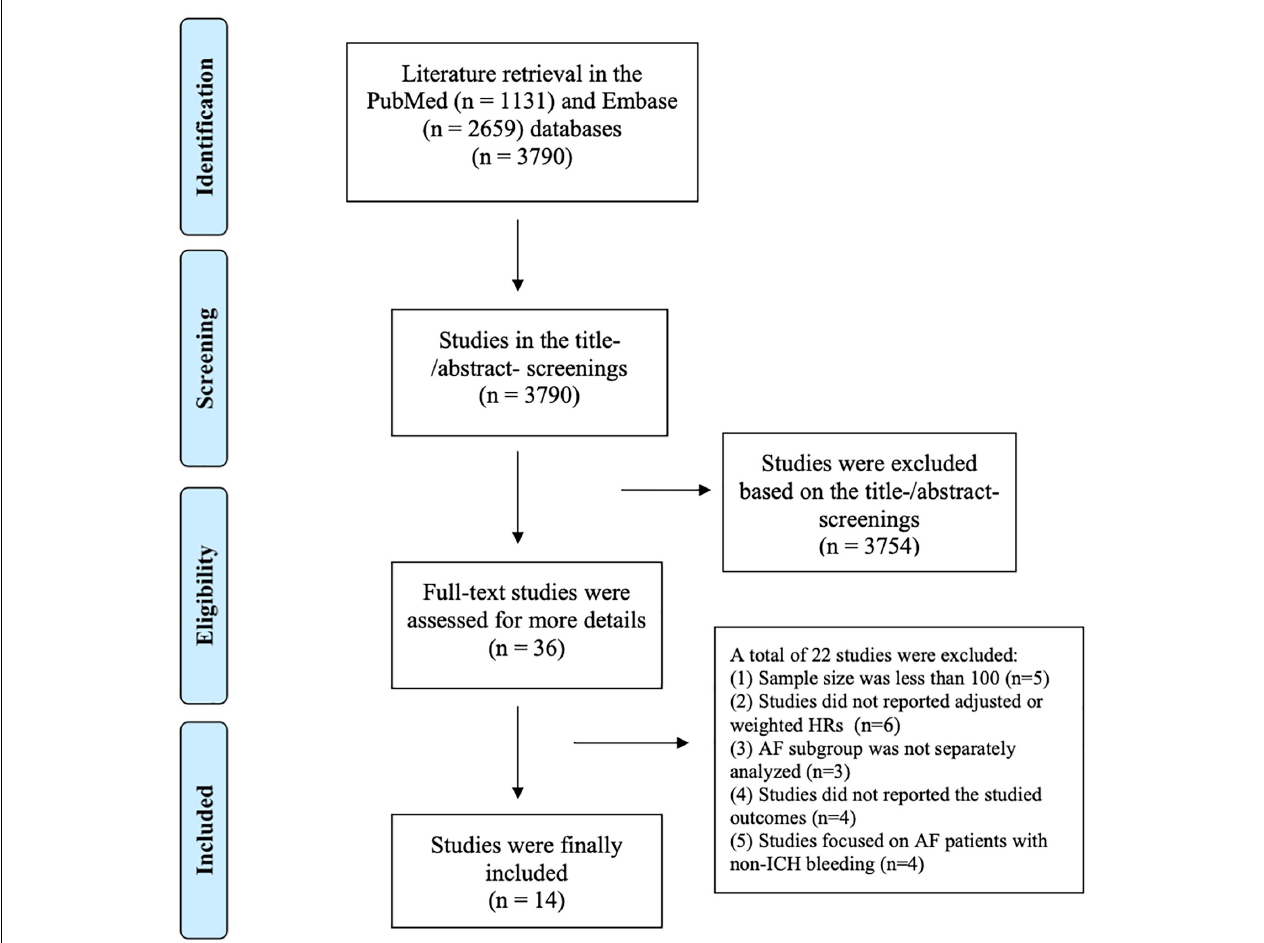
FIGURE 1 | The flow chart of literature retrieval of this